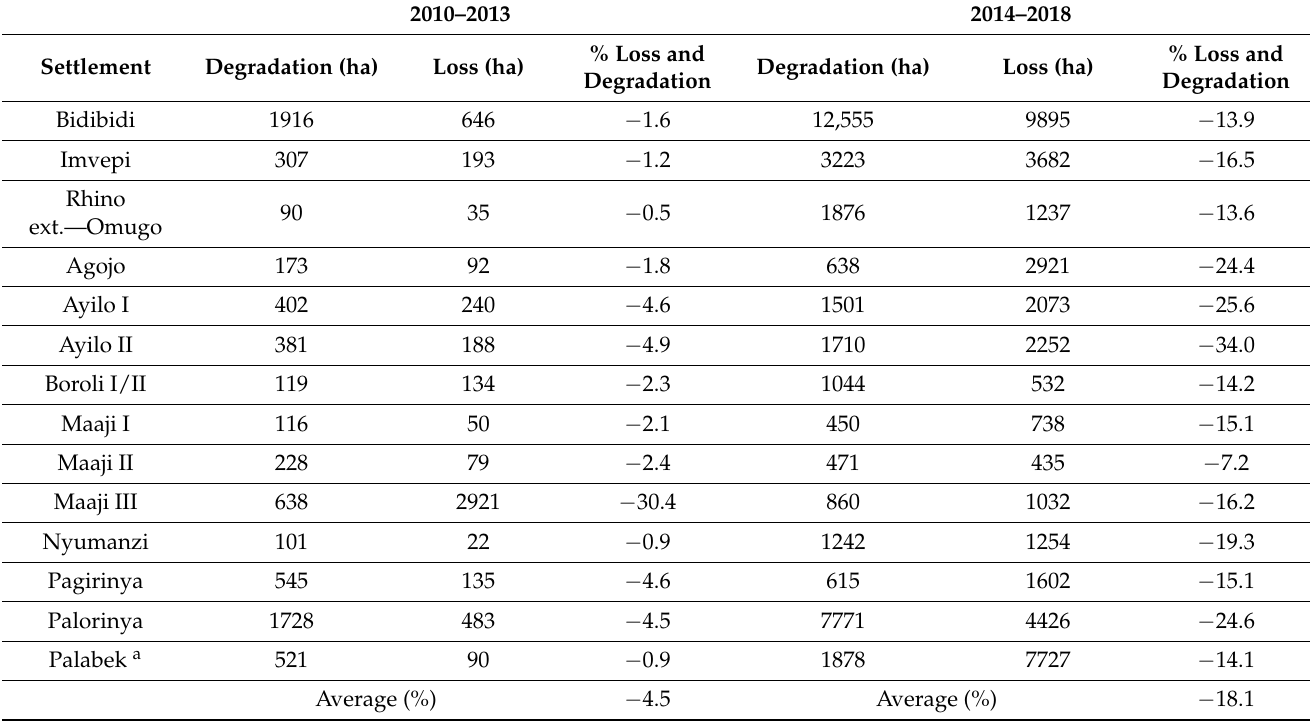
Table 10. Summary of degradation and loss (in ha) per settlement within 5 km in northern